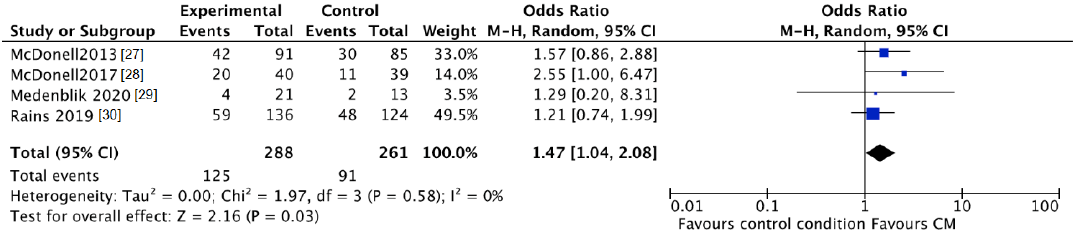
Figure 5. Forest plot of the comparison CM versus standard care after follow-up, percentage of participants with negative samples.